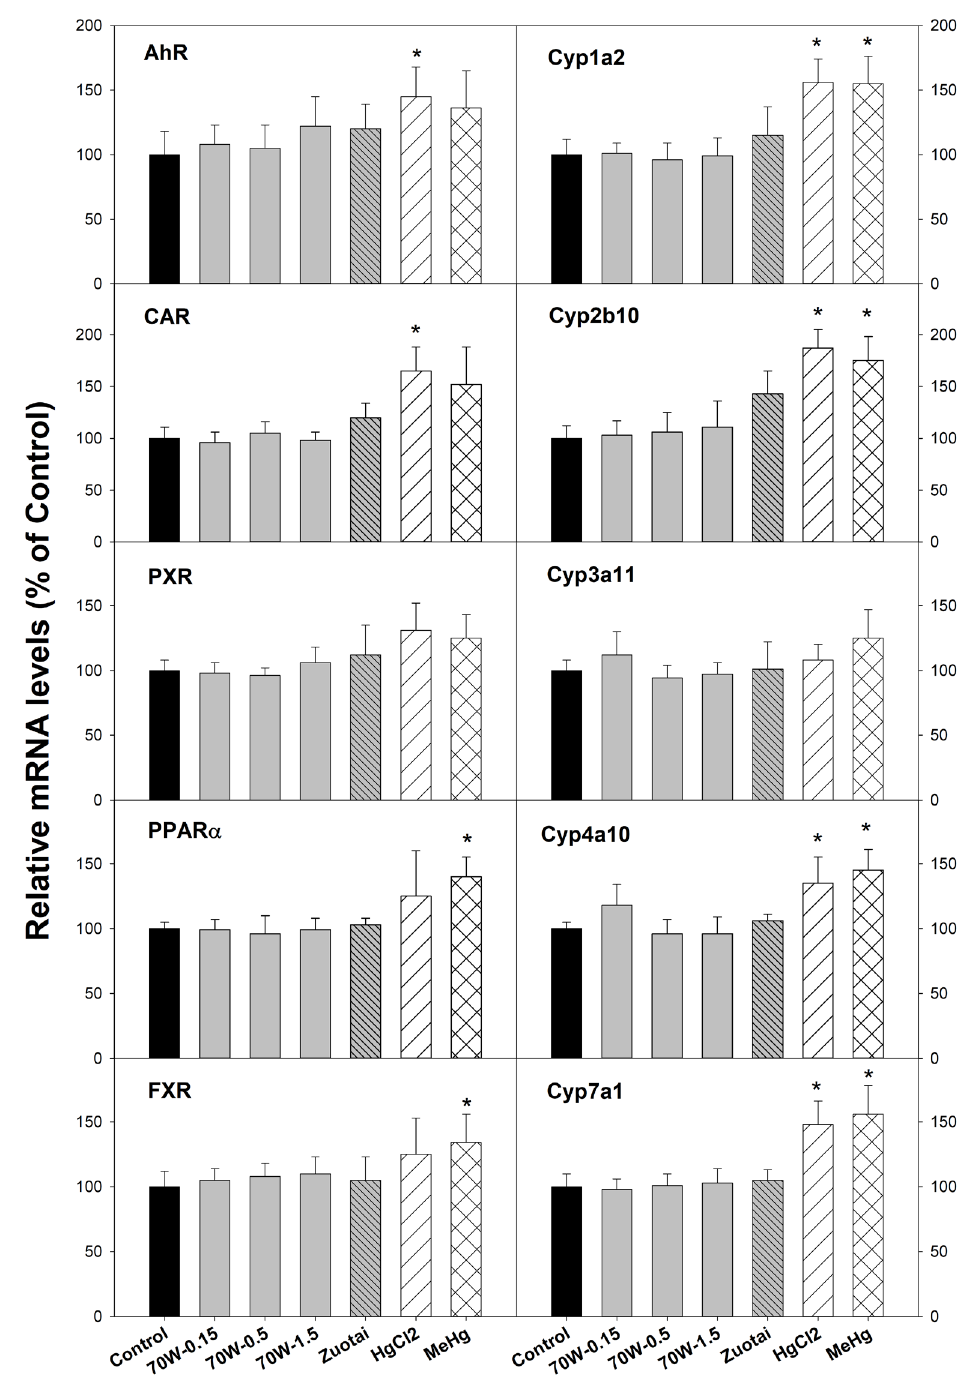
Figure 1. Effect of 70W and mercury compounds on nuclear receptor and corresponding CYP gene expression. Mice were given 70W 0.15, 0.5, and 1.5 g/kg, po. Zuotai (30 mg/kg, po), HgCl (33.6 mg/kg, po), and MeHg (3.1 mg/kg, po) daily for seven days, and 2 hepatic total RNA and protein were extracted for RT-PCR analysis. Data are mean ± SE, n = 5. *Significantly different from control, p < 0.05.